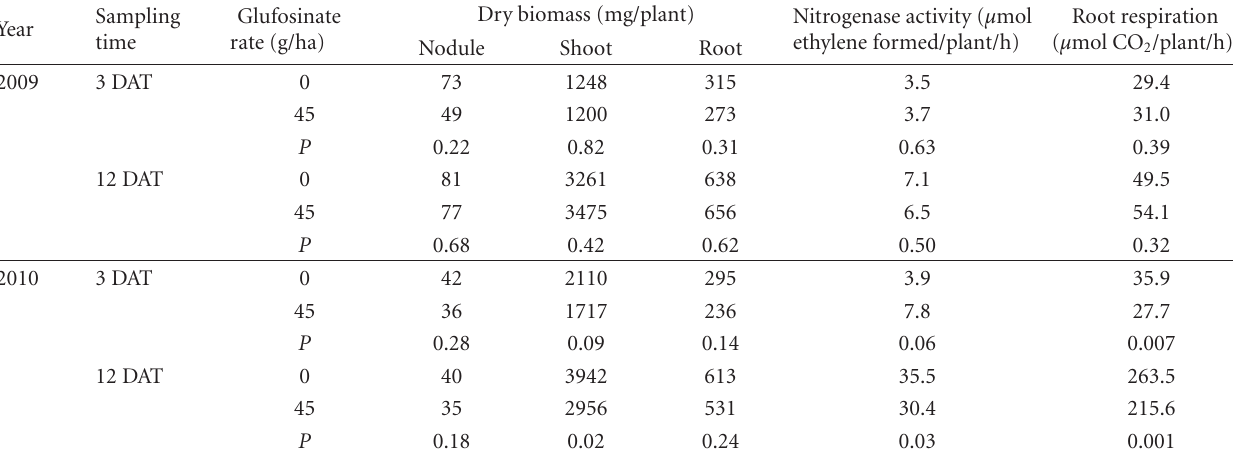
Table 4: Glufosinate e ff ect on shoot, root, and nodule biomass, nitrogenase activity, and root respiration in conventional (glufosinate and glyphosate sensitive) soybean under field conditions in 2009 and 2010.